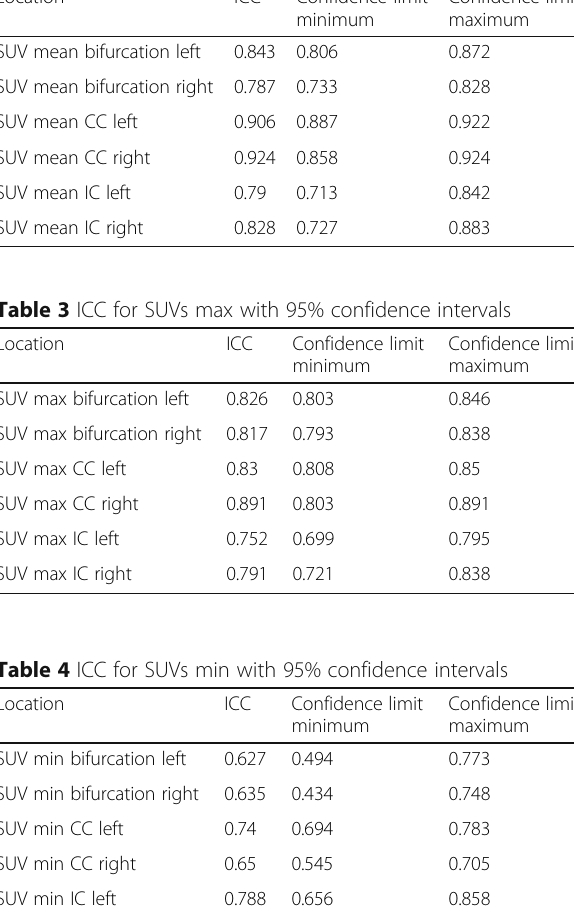
Table 2 ICC for SUVs mean with 95% confidence intervals Location ICC